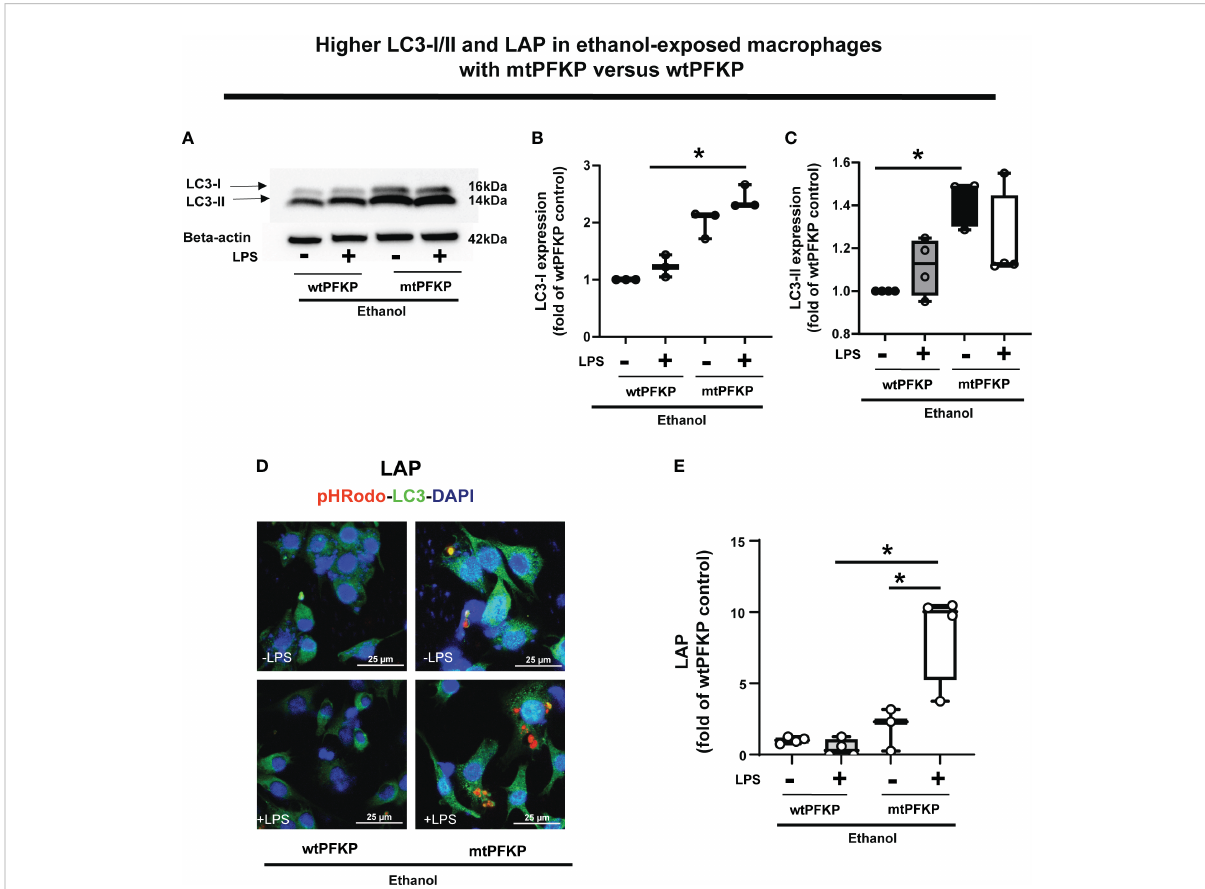
FIGURE 9 Effect of LC3-I/II and LC3-associted phagocytosis in Ethanol-exposed macrophages with wtPFKP and mtPFKP. (A) Western blot analysis of LC3-I and LC3-II expression in Ethanol-exposed RAW 264.7 cells with wtPFKP or mtPFKP transfection± LPS. Western blot image quanti fi cation of Ethanol-exposed RAW 264.7 cells with wtPFKP or mtPFKP transfection± LPS for LC3-I in (B) and LC3-II in C (n = 4 blots; * p < 0.05). (C, D) Representative images of intracellular pHrodo bioparticles (Red) and LC3 (green) showing LAP in Ethanol-exposed RAW264.7 cell macrophages transfected with wtPFKP or mtPFKP± LPS. (E) LAP quanti fi cation: For each image in “ E ” , the co-localization of intracellular pHrodo (red) and LC3 (green) were determined as LC3-associated phagocytosed particles and divided by the total numbers of cells (nuclei). Graph represents fl uorescence quanti fi cation of LAP in WT-BMDM (n=4; *